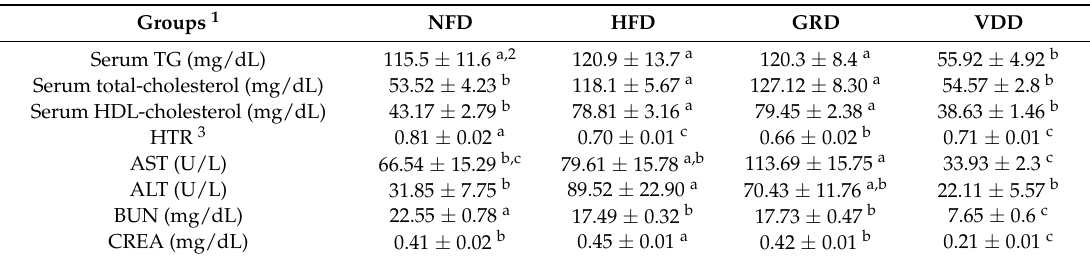
Table 4. Effects of Valeriana dageletiana Nakai ex F. Maek extract from the above-ground part (VDAE) on obese biomarkers in mice fed a high-fat diet.